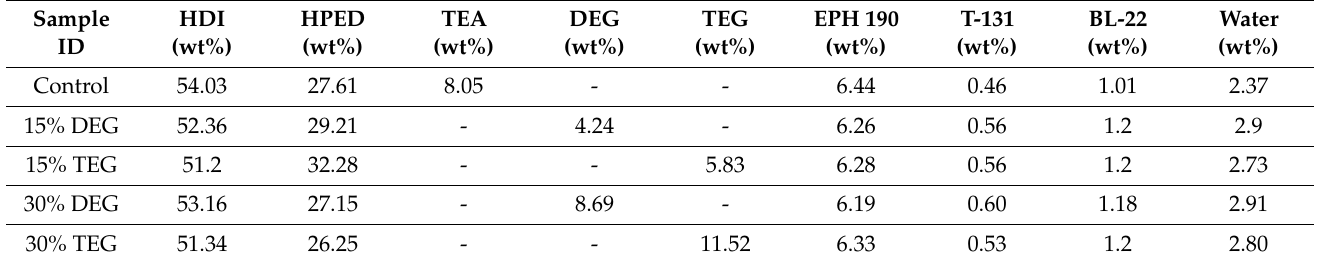
Table 1. Synthesized foam